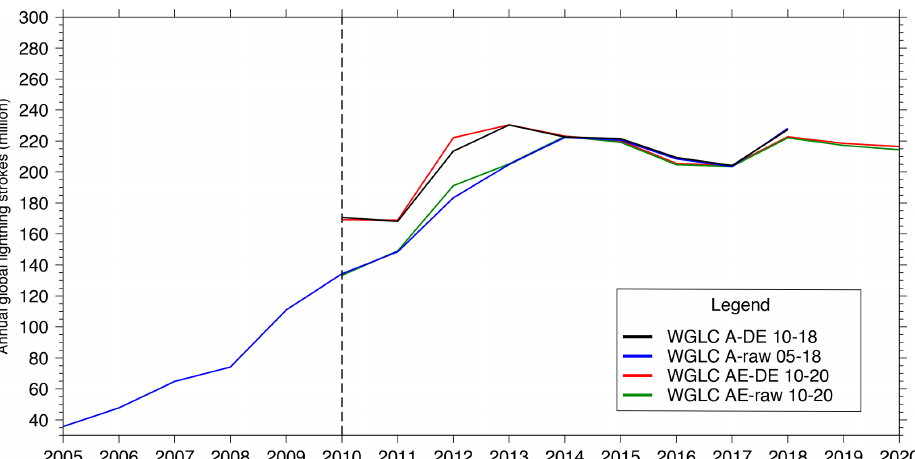
Figure 2. Total global lightning strokes from 2005 to 2020. WWLLN produces two sets of raw lightning discharge data: A (A-raw) and AE (AE-raw). The A-DE and AE-DE curves are adjusted for the WWLLN-reported detection efficiency. Detection efficiency and AE data were produced starting in 2010. WWLLN “A” data (A-raw and A-DE) are shown for illustrative purposes and only up to 2018.